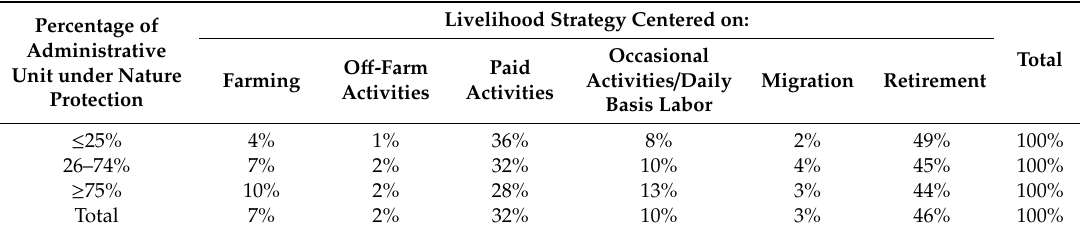
Table 3. Livelihood strategies related to the community